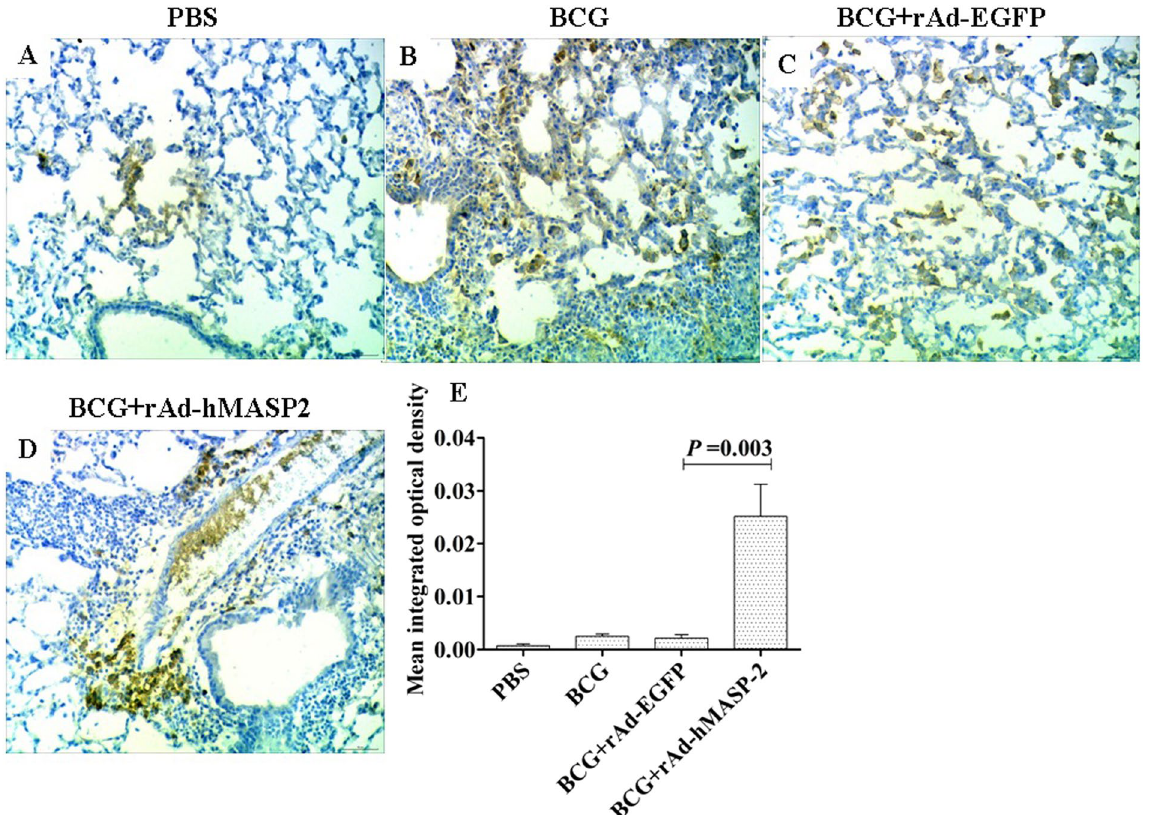
Figure 4. The lung tissue from BCG-infected BALB/c mice was stained for the deposition of C4 by immunohistochemistry for estimating the MASP-2 complex activity. ( A ~ D ) C4 deposition analysis of immunohistochemical stained lung sections from 4 representative mice ( × 200). As compared with other groups, the lung lesions tissue showing strong staining for C4 in rAd-hMASP-2 group. ( E ) Mean integrated optical density (IOD) of C4 deposition detemined by Image Pro-Plus according to the staining intensity by visual assessment, n = 4 per group. Each point represents the mean of four